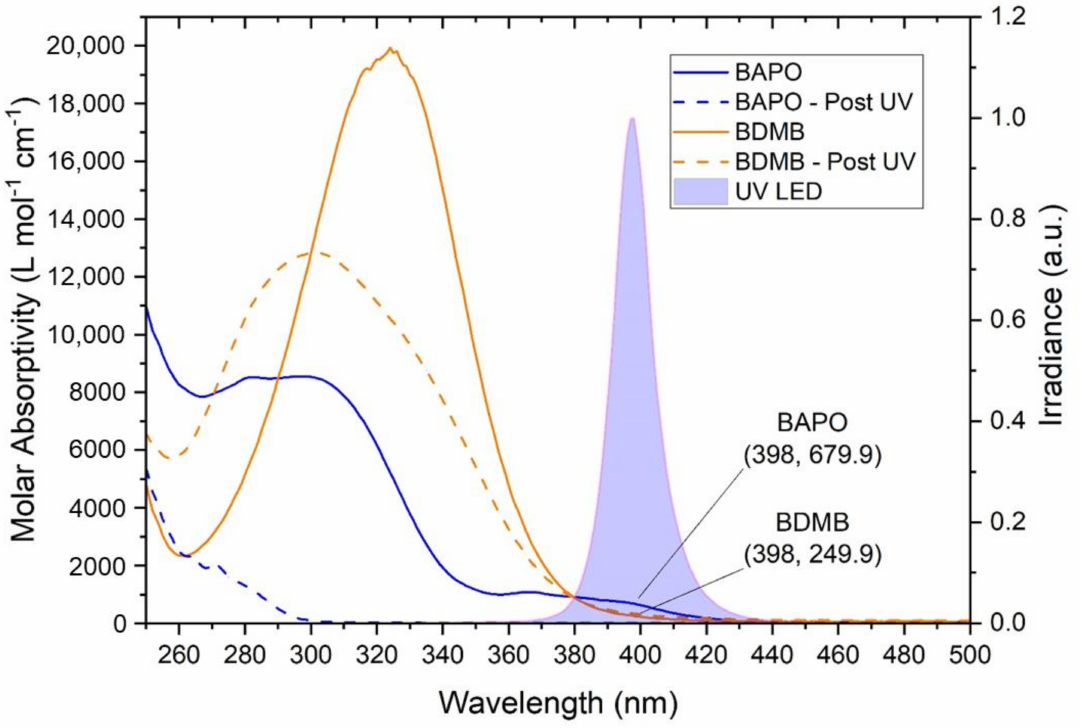
Figure 5. The molar absorptivity of BAPO and BDMB, with the reaction byproduct molar absorptivity indicated by ‘Post UV.’ The absorptivity is compared with the spectral output of an Altair 75 lamp, with the measured spectral output indicating a peak UV output at 398